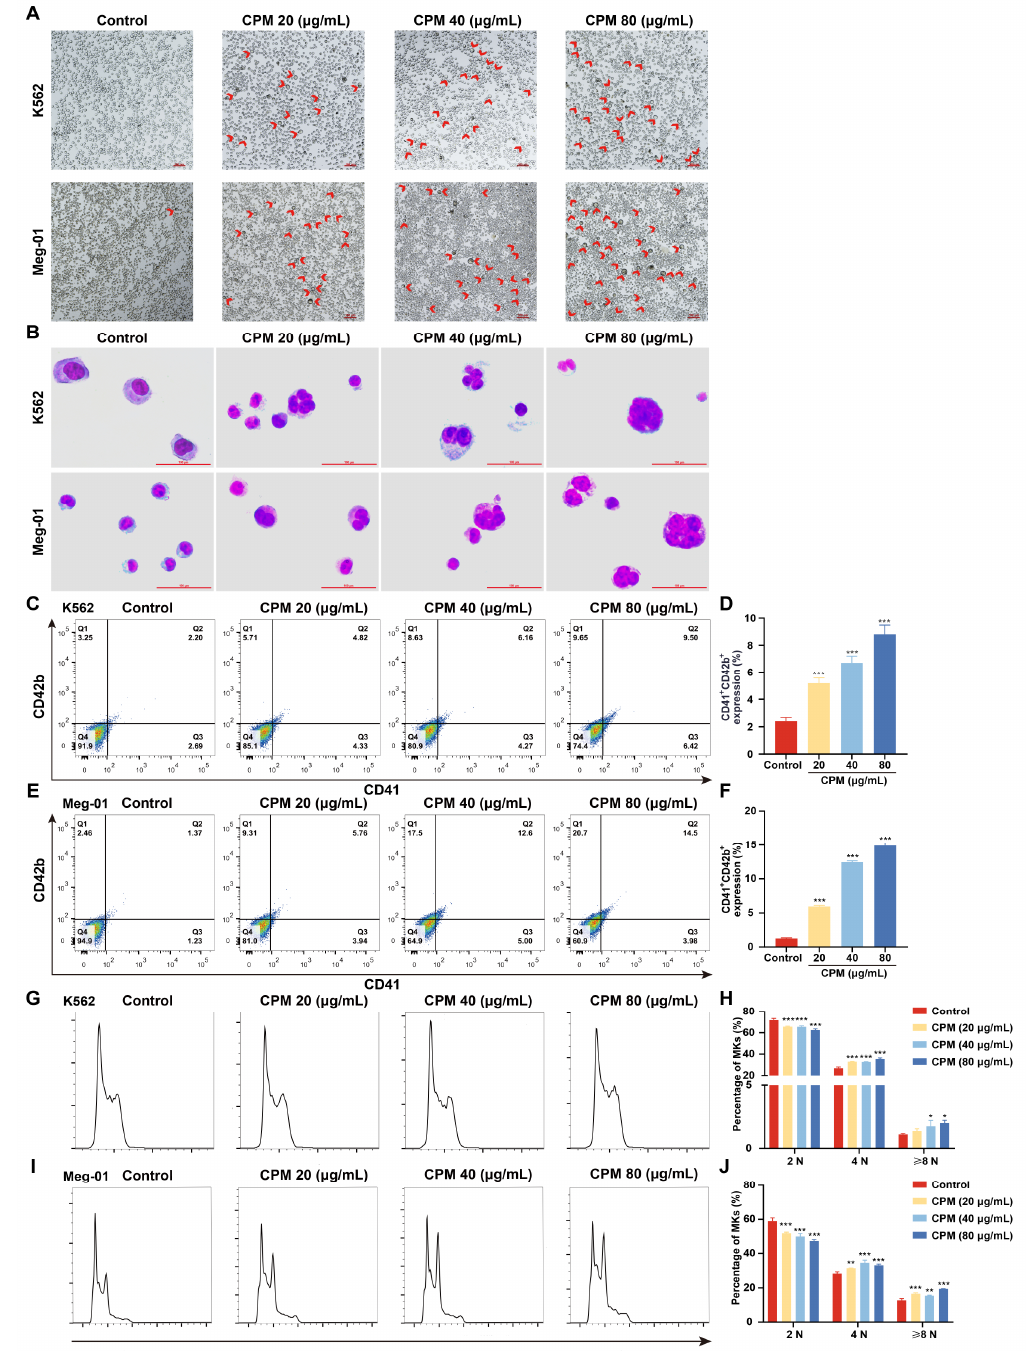
Figure 1. CPM induces MK differentiation. ( A ) Microscope photographs of K562 and Meg-01 cells with or without CPM (20, 40 and 80 µ g/mL) treatment for 5 days. Scar bar: 100 µ m. Microscopy fields were captured randomly at 10 × resolution. ( B ) Giemsa staining of K562 and Meg-01 cells with or without CPM (20, 40 and 80 µ g/mL) treatment for 5 days. Scar bar: 100 µ m. ( C , E ) CD41 and CD42b expression of K562 and Meg-01 cells with or without CPM (20, 40 and 80 µ g/mL) treatment for 5 days. ( D , F ) The proportion of CD41 + CD42b + cells in control and CPM-treated groups. Data are mean ± SD (n = 3). ( G , I ) DNA ploidy analysis of K562 and Meg-01 cells with or without CPM (20, 40 and 80 µ g/mL) treatment for 5 days. ( H , J ) The percentage of 2 N, 4 N and ≥ 8 N cells in each group. Data are mean ± SD (n = 3, ANOVA). * p < 0.05, ** p < 0.01, *** p < 0.001 vs. the control